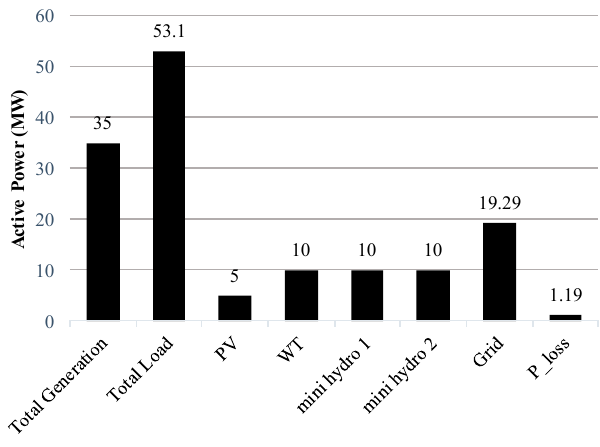
Figure 9. Overall active power characteristics of the test network.